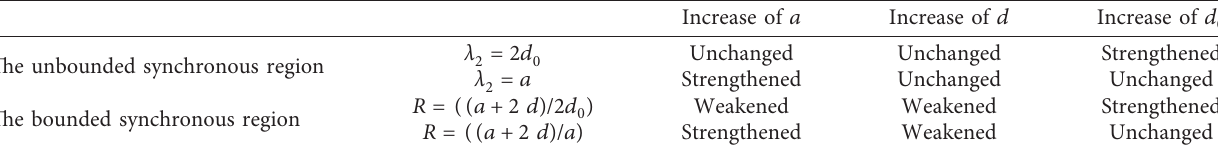
of Network I when N is even. 0